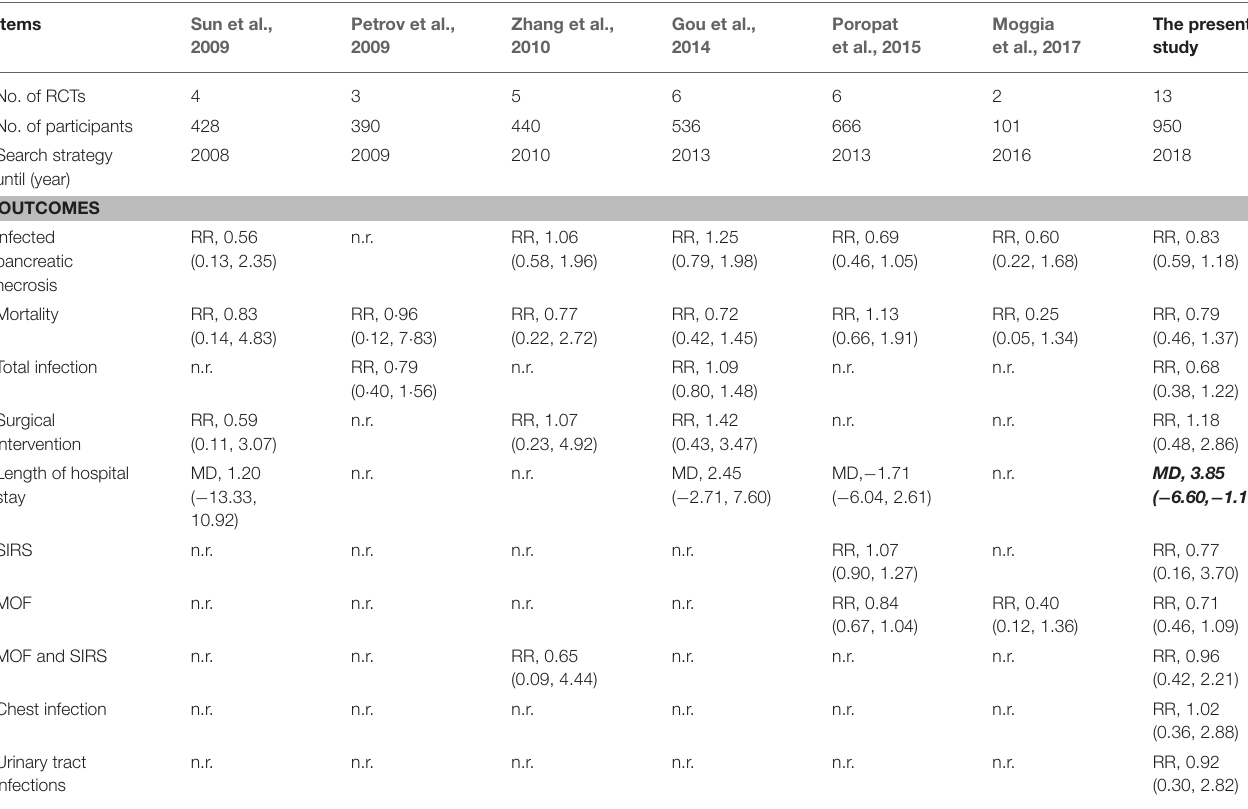
TABLE 2 | Meta-analyses of pre-, pro-, and synbiotics in severe acute pancreatitis.